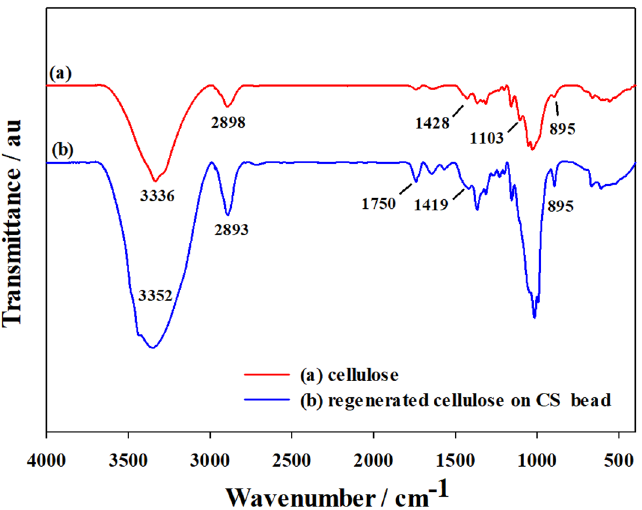
Figure 4. FT-IR spectral data of original cellulose ( a ) and regenerated cellulose on CS bead ( b ). Original cellulose was in powder form and regenerated cellulose was separated from cellulose-coated CS bead.